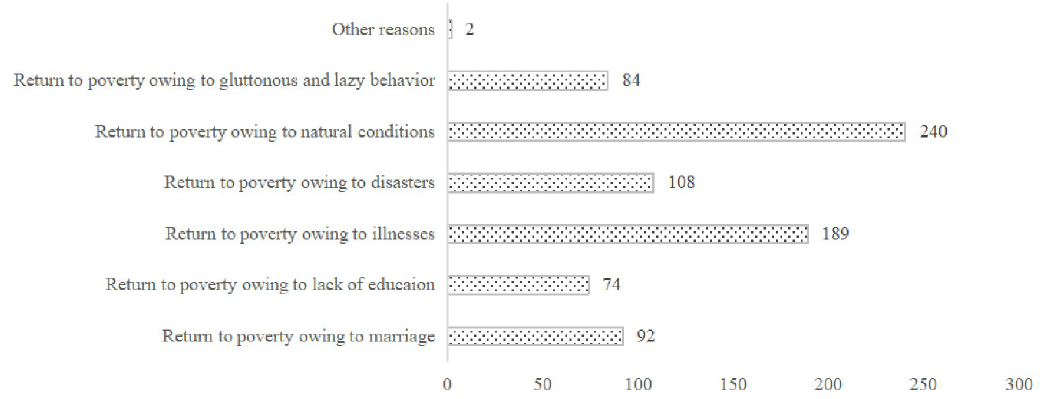
Fig 5. Distribution of reasons for rural households returning to poverty after escaping it in the